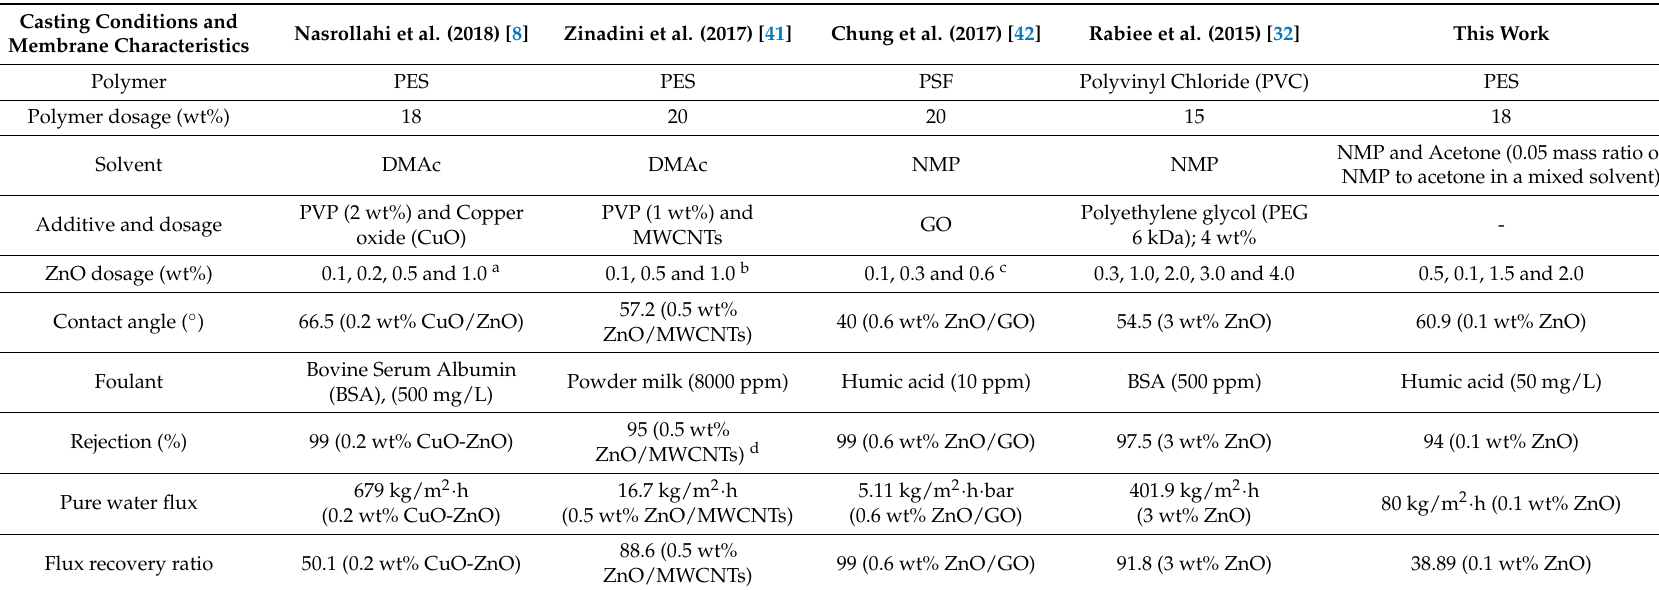
Table 5. Comparison between this study and similar